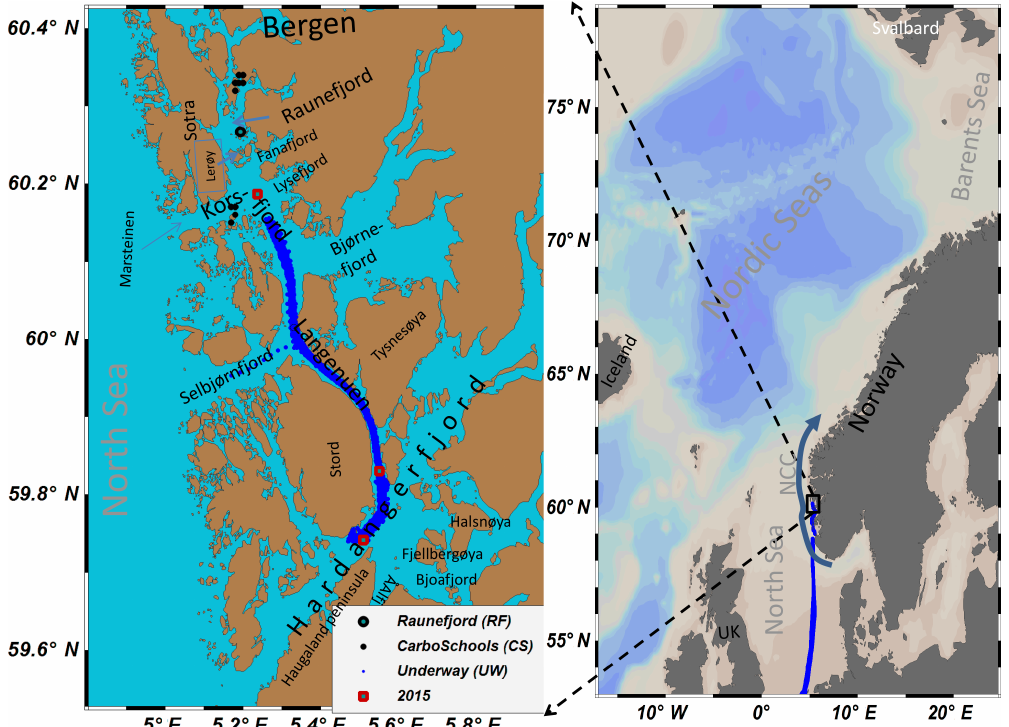
Figure 1. An overview map of western Norway with a detailed map of the study area showing the positions from where cruise and underway data have been acquired. The thick arrow on the right panel indicates the approximate position of the Norwegian Coastal Current